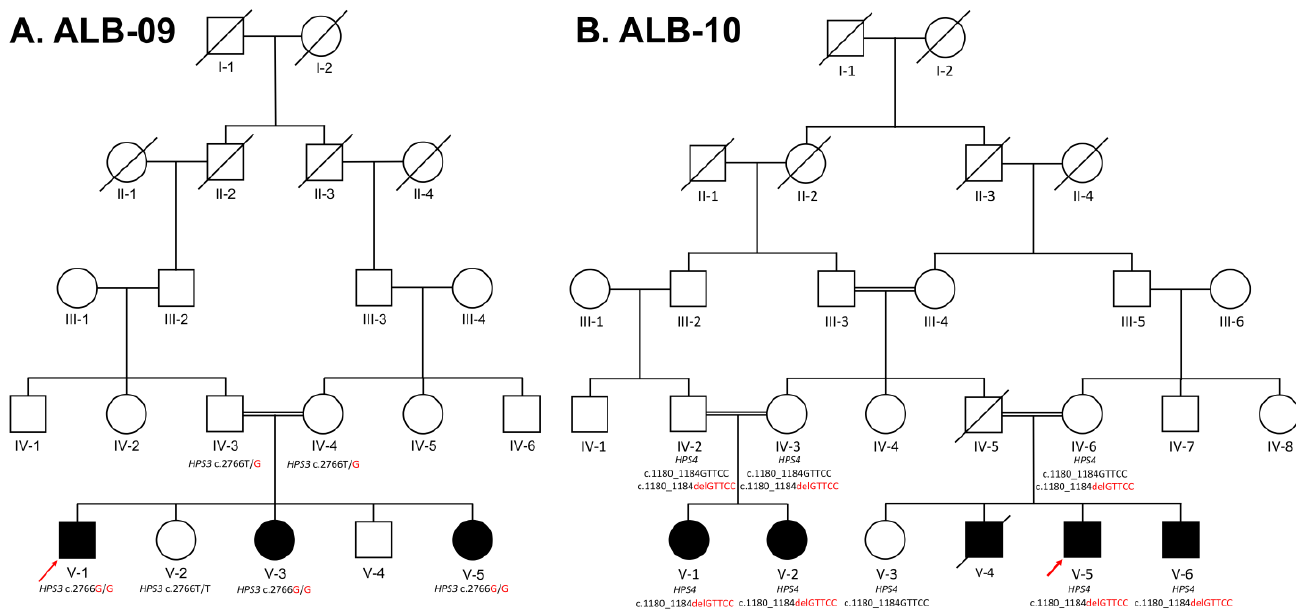
Figure 1. ( A ). ALB-09, five-generation pedigrees, showing autosomal recessive Hermansky – Pudlak syndrome type 3. The index patient V-1 is indicated with an arrow, and the genotypes of those family members are written below their symbols whose samples were available for Sanger sequencing. The three affected siblings (V-1, V-3, and V-5) have homozygous alleles, while one unaffected sibling (V-2) has homozygous wild-type alleles, and their parents (IV-3 and IV-4) have heterozygous alleles for HPS3 c.2766T > G. ( B ). ALB-10, a five-generation pedigree, presenting autosomal recessive